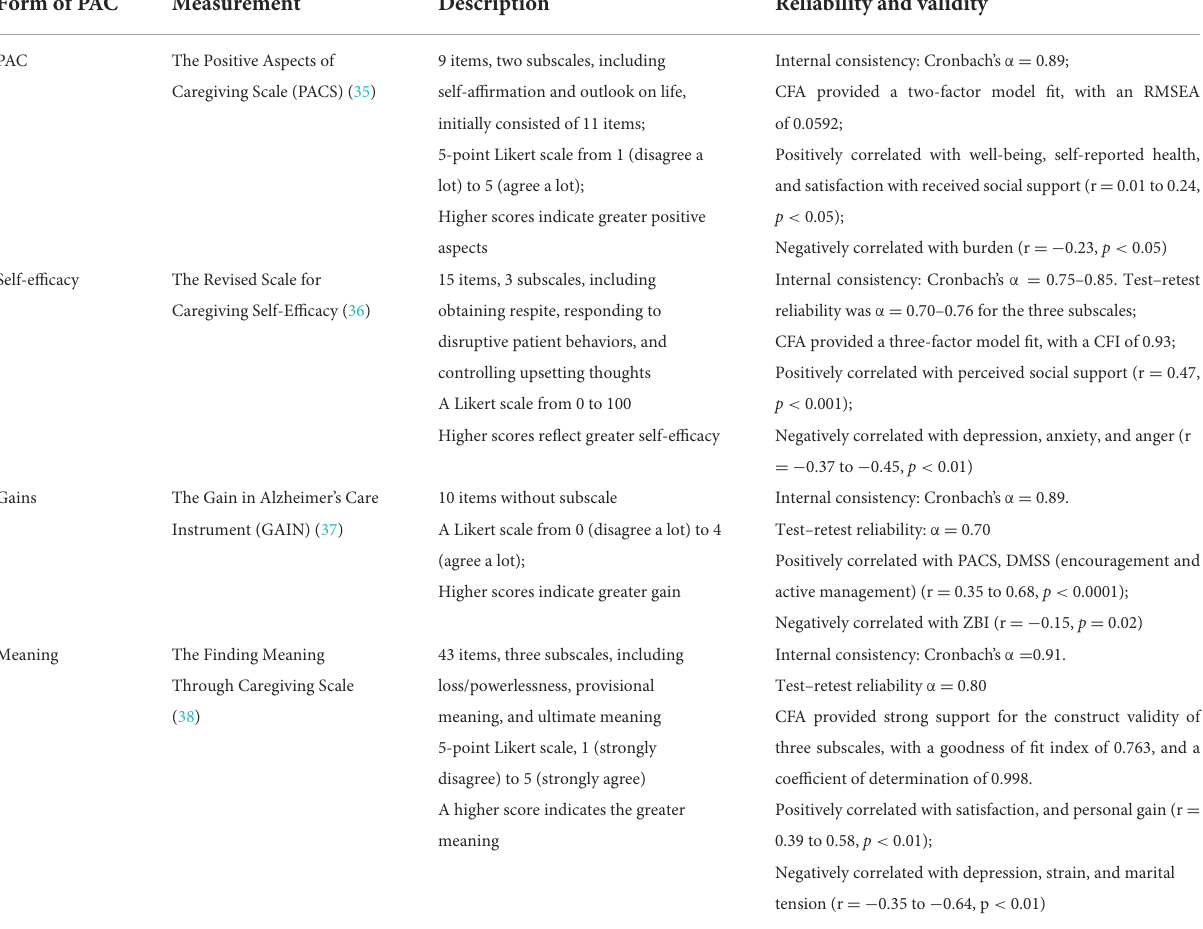
TABLE 2 Description of the measurements most cited included in the